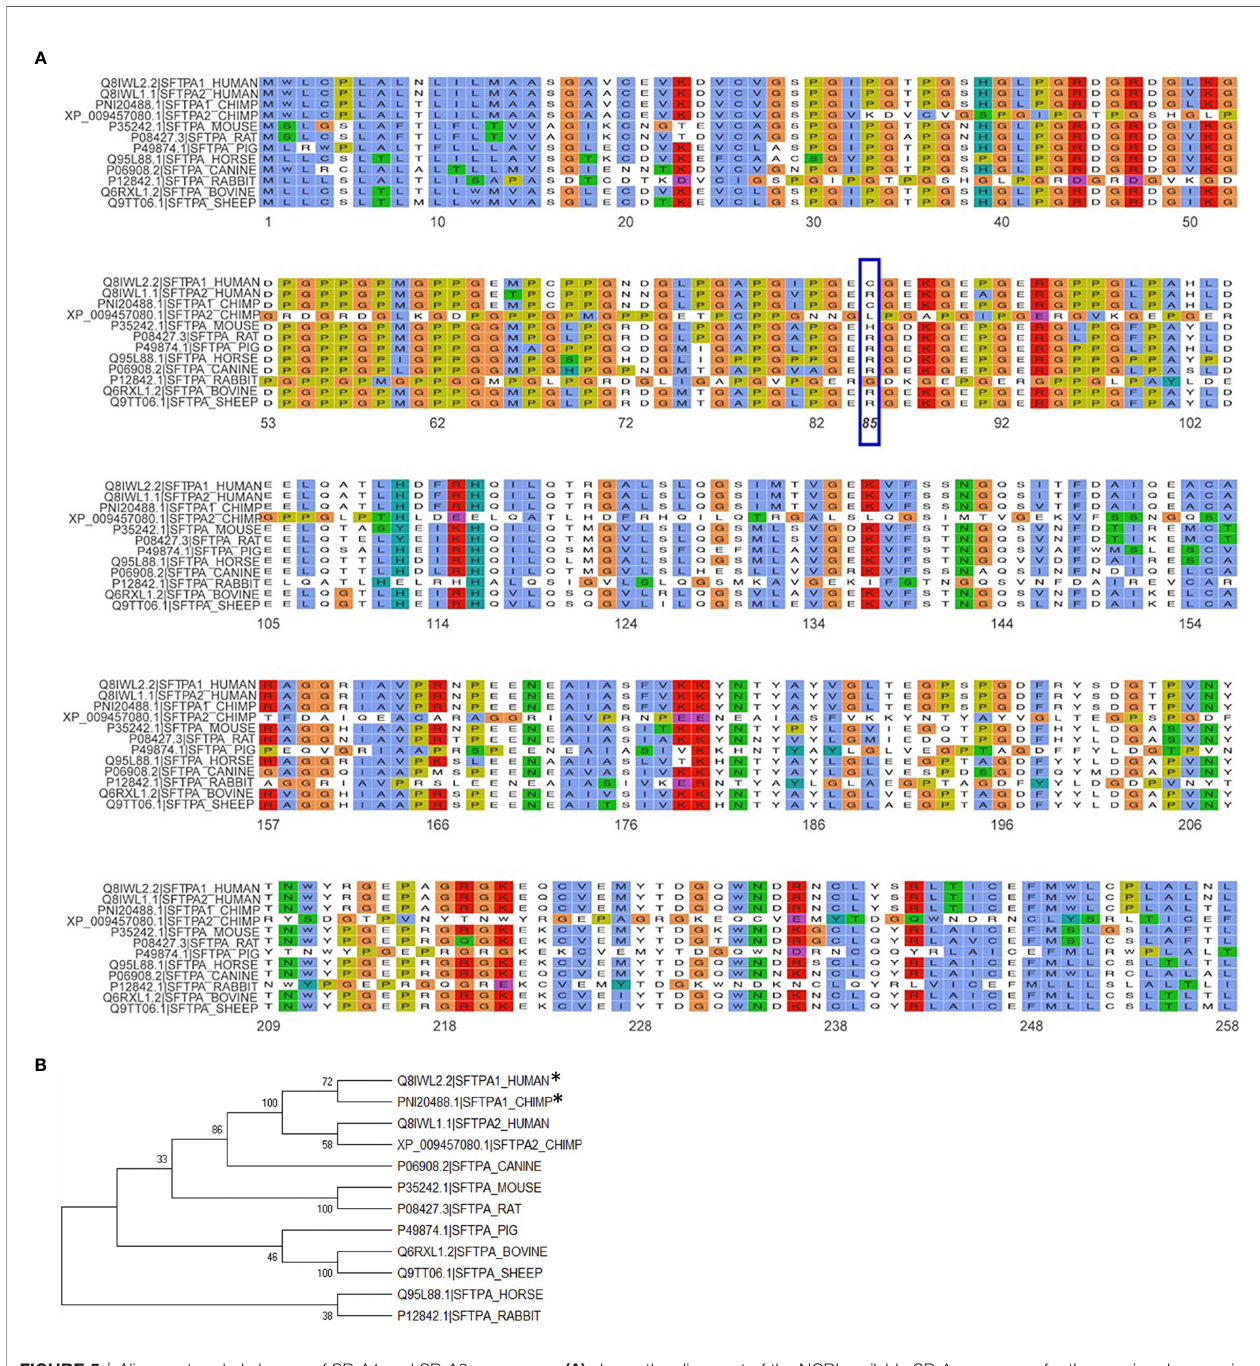
FIGURE 5 | Alignment and phylogeny of SP-A1 and SP-A2 sequences. (A) shows the alignment of the NCBI available SP-A sequences for the species shown using the ggmsa R package (http://yulab-smu.top/ggmsa/index.html). Per NCBI statement “ this record is predicted by automated computational analysis. This record is derived from a genomic sequence (NC_036889.1) annotated using gene prediction method: Gnomon, supported by mRNA and EST evidence ” . Gnomon, a gene prediction tool, looks for ORFs, splice sites etc. The amino acid of residue 85 is highlighted by the blue box. The color scheme follows the default colors used in alignments in Clustal X. (B) shows the phylogenetic tree of the sequences shown in (A) . The tree was created with the MEGA X software (www.megasoftware.com), using the neighbor-joining method. The numbers next to the branches represent the percentage of replicate trees in which the associated taxa clustered together in the bootstrap test (1000 replicates). The asterisk mark the two sequences, human SP-A1 and primate SP-A1 sequence, that have a C (Cys) at residue 85. All other species sequences have an R (Arg) except for the mouse that has a H (His) and the primate SFTPA2 gene that has an L (Leu), as shown in (A)